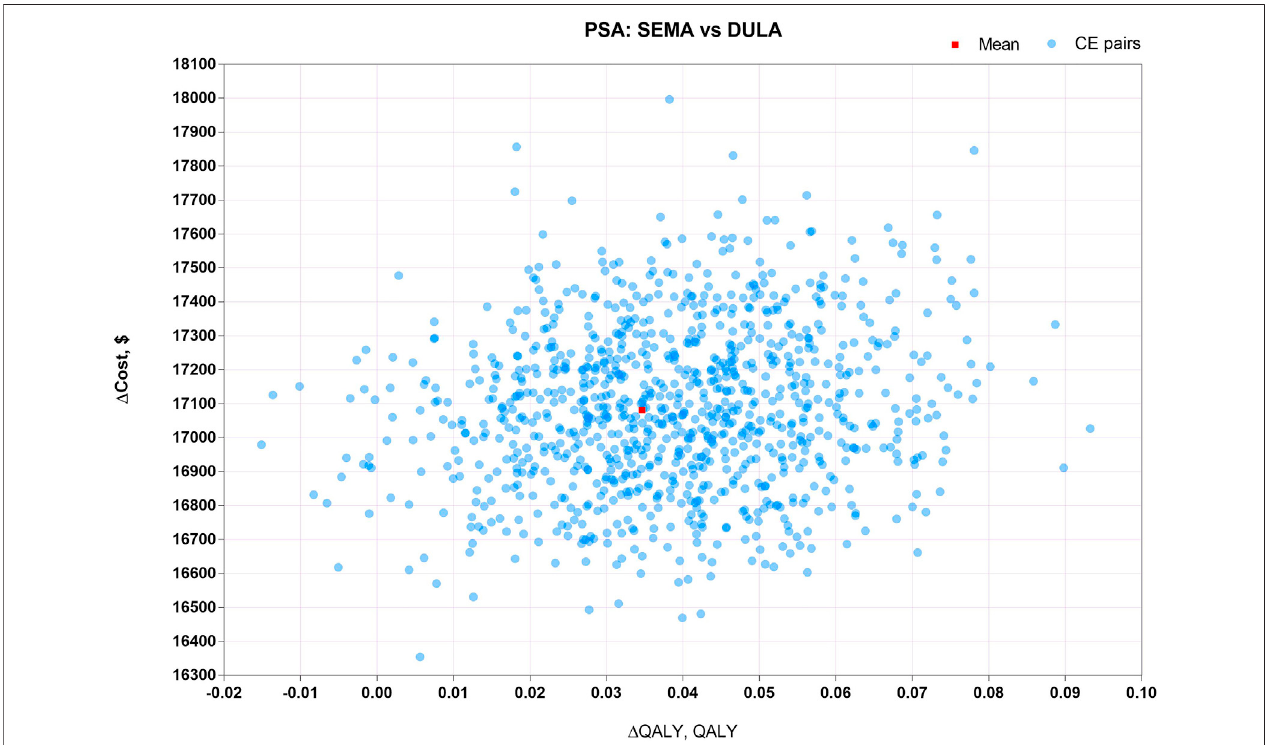
FIGURE 3 | Scatter plots of ICUR for sc. SEMA vs.